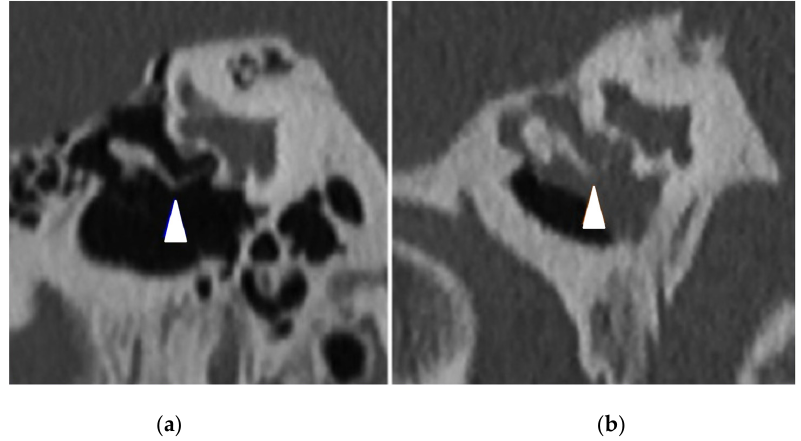
Figure 4. Right temporal bone CT scans in coronal view showing (white arrowheads) ( a ) a normal